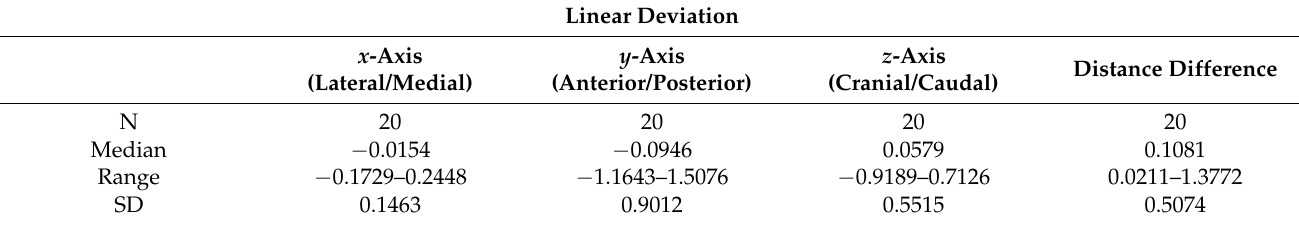
Table 2. Linear deviations in the x -, y -, and z -axis at 20 selected reference